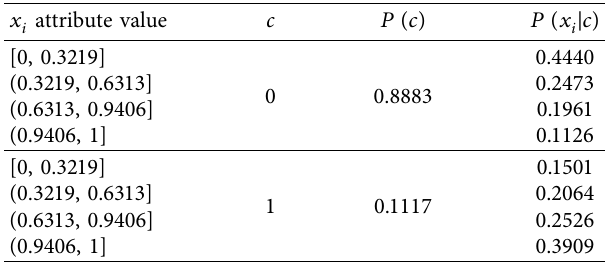
Table 3: Naive Bayes classifier parameter model for distance